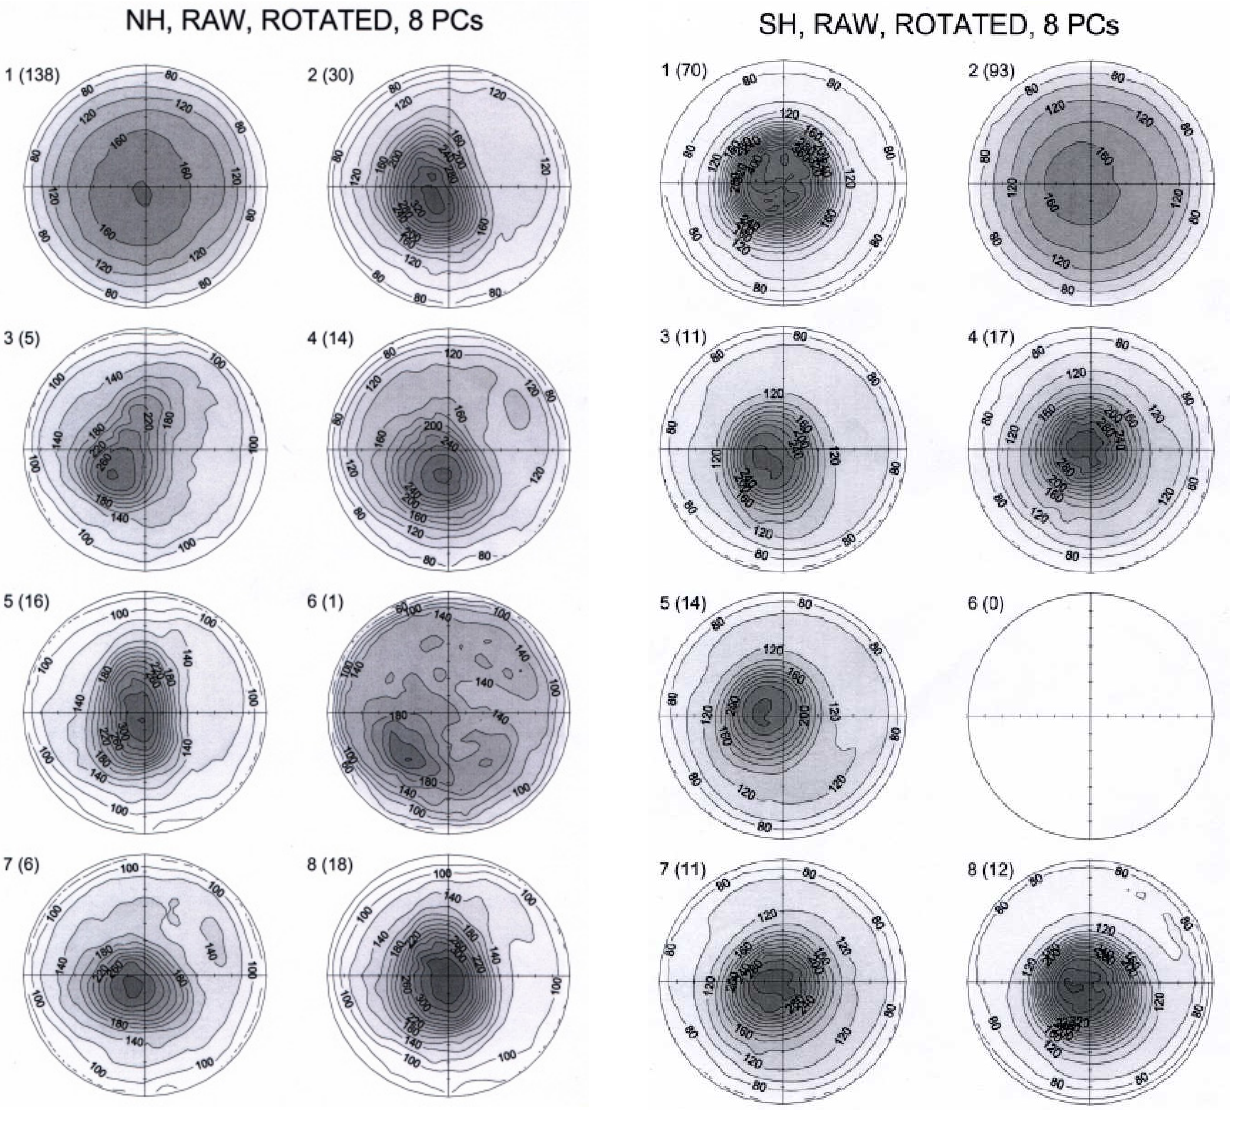
Fig. 4. As in Fig. 2 except for 8 rotated PCs of raw data. Fig. 5. As in Fig. 3 except for 8 rotated PCs of raw